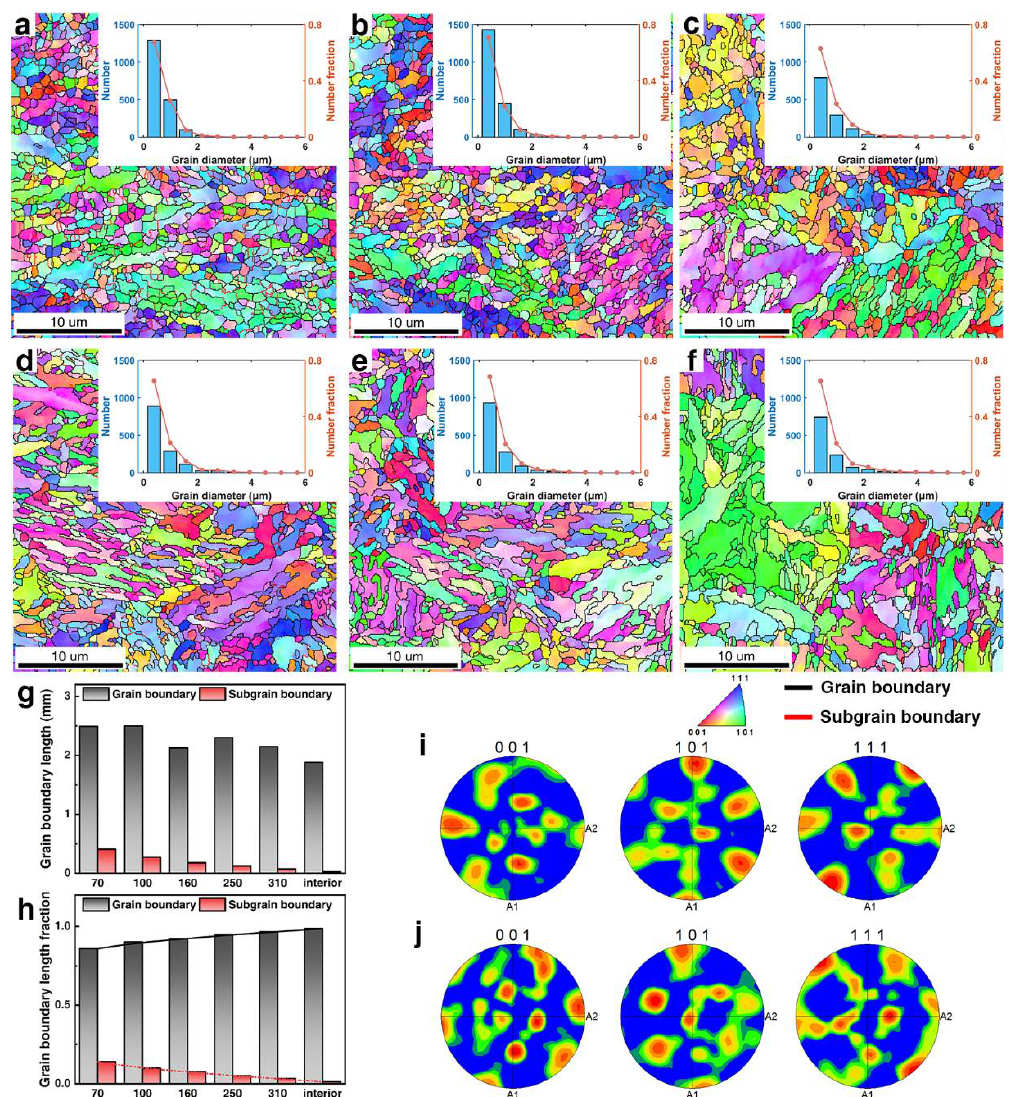
Figure 5. Inverse pole figure of the rolled bolt at different distances from the surface of the thread with the frequency distribution of grain diameter: ( a ) 70 μm ( b ) 100 μm ( c ) 160 μm ( d ) 250 μm ( e ) 310 μm ( f ) interior region. ( g , h ) Histogram of the grain and sub-grain boundary length and fraction corresponding to ( a , f ). ( i , j ) Pole figure corresponding to ( a , f ).